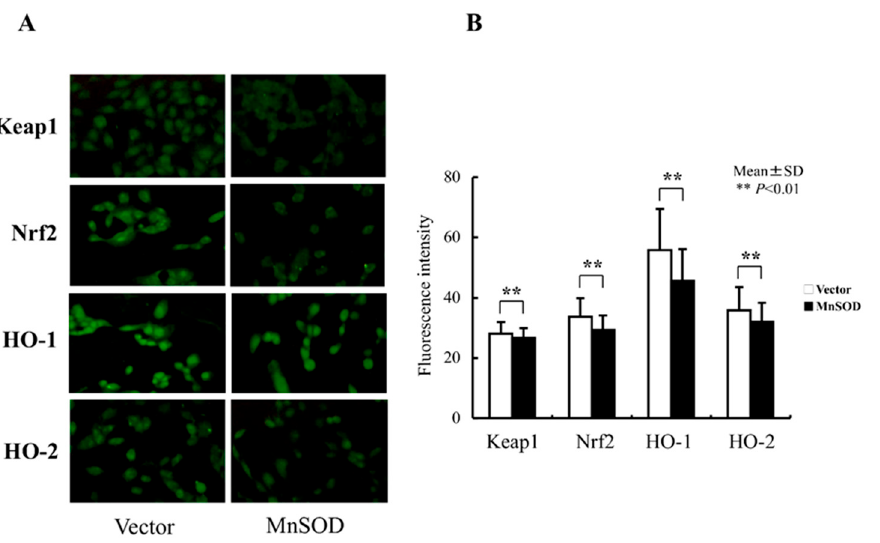
Figure 6. Changes in oxidative - stress - related protein expression following hMnSOD transfection into RGK1 cells . ( A ) Laser confocal images of fluorescence - stained cells . Mag- nification × 20 . ( B ) Semiquantitative fluorescent detection of target proteins in hMnSOD - vector - transfected cells ( MnSOD ) and the cells transfected with vector alone ( Vector ). The fluorescence intensity in hMnSOD - vector - transfected cells was significantly decreased compared with that in the cells transfected with vector alone, suggesting hMnSOD gene transfection worked in mitochondria and decreased the ROS levels, resulting in lower Keap1, Nrf2, HO - 1, and HO - 2 fluorescence levels . Bar : mean ± S . D . ; t - test . ** p < 0 . 01 .